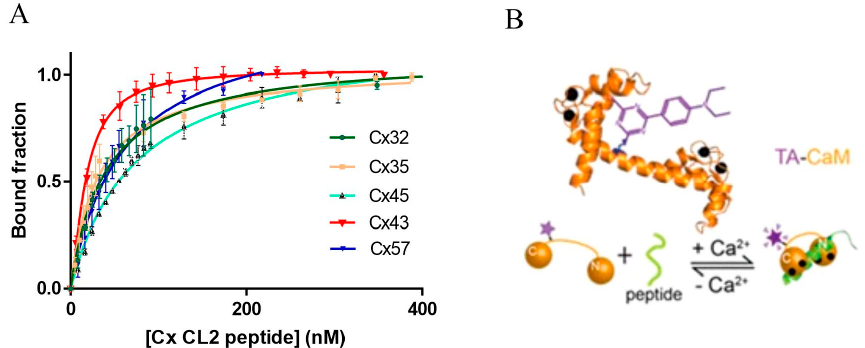
Figure 2. Ca 2+ -dependent CaM binding of Cx CL2 peptides. ( A ) Equilibrium binding of 10 nM Ca 2+ /TA-CaM to Cx CL2 peptides in 50 mM HEPES-K + , 100 mM KCl, 2 mM MgCl 2 and 100 µ M CaCl 2 , pH 7.5 at 20 °C. The fluorescence intensity of Ca 2+ /TA-CaM derivatives decreased upon peptide addition. The data were corrected for dilution, inverted, normalised and the bound fraction is plotted against the Cx CL2 peptide concentration. The error bars represent S.D. ( B ) Schematic drawing of TA-CaM, TA-Cl is covalently bound to Lys 75 [45]. Binding of Ca 2+ to TA-CaM in the presence of peptide leads to a fluorescence emission increase of the fluorophore (purple star). Table 2. Interaction of Cx CL2 peptides with TA-CaM and DA-CaM in the presence of Ca 2+ .